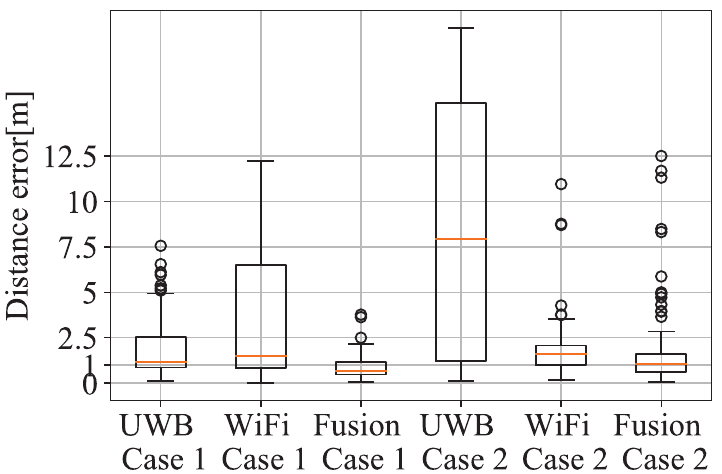
Figure 5. Horizontal error distribution of UWB + WiFi FTM for Cases 1 and